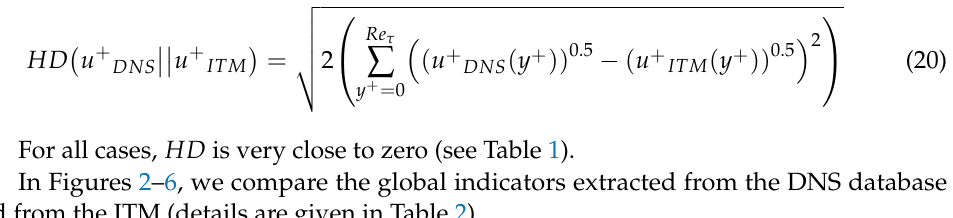
Fluids 2023 , 8 , x FOR PEER REVIEW Figure 2. Trend of the mean velocity U b + and of the centerline velocity U c + ; • DNS data; and – ITM. Figure 2. Trend of the mean velocity ITM.